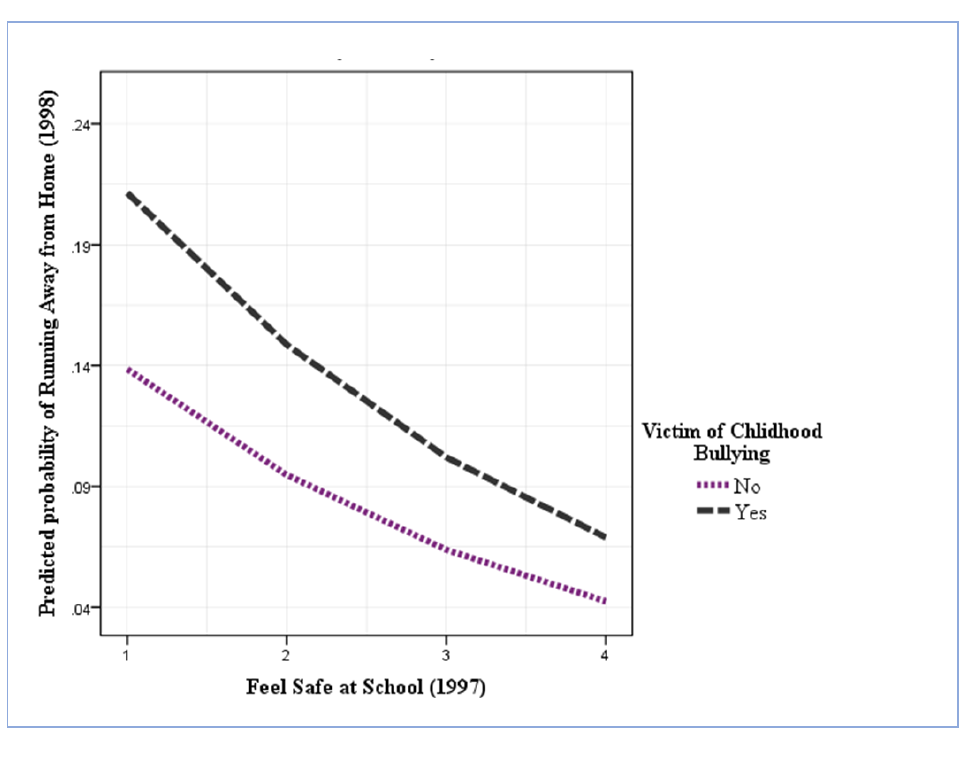
Figure 1. Predicted Probability of Running Away From Home by Perception of School Safety and Bully